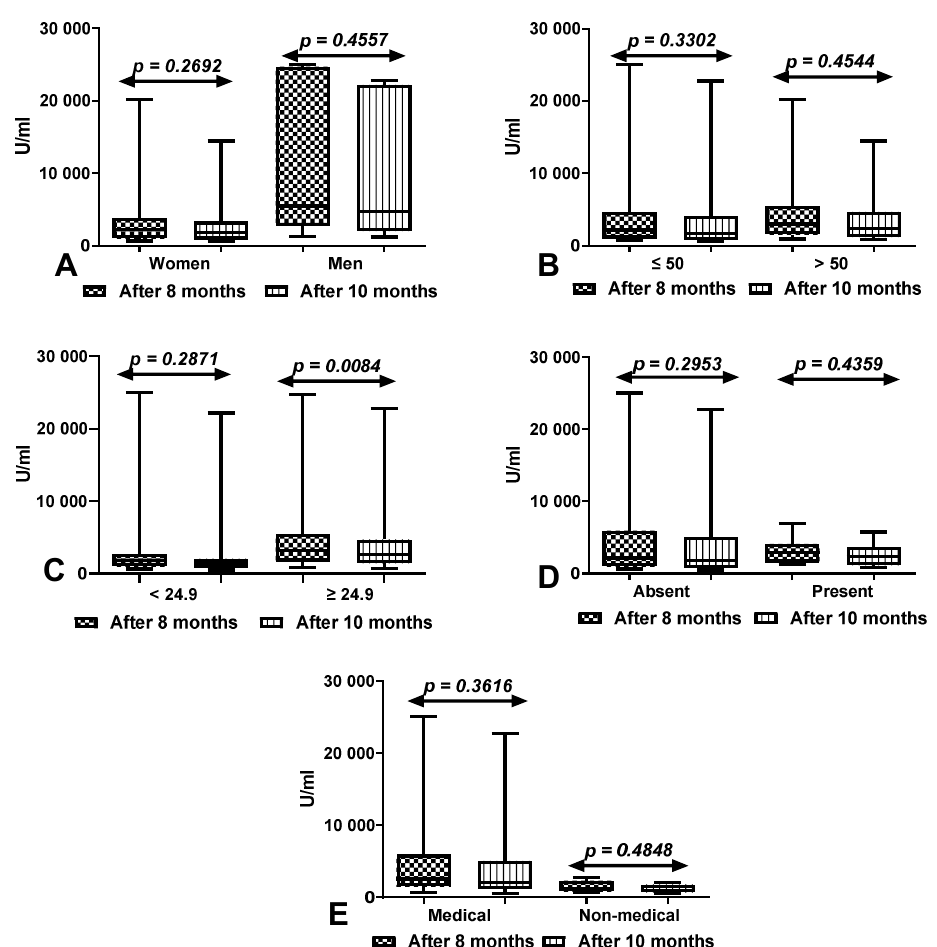
Figure 3. ( A ) Comparison of total anti-SARS-CoV-2 antibody levels between first (after 8 months) and second determination (after 10 months) in the groups of women and men with a history of COVID-19. The data are presented as median (minimum–maximum). ( B ) Comparison of total anti- SARS-CoV-2 antibody levels between first (after 8 months) and second determination (after 10 months) in the groups of patients under and over the age of 50 with a history of COVID-19. The data are presented as median (minimum–maximum). ( C ) Comparison of total anti-SARS-CoV-2 an- tibody levels between first (after 8 months) and second determination (after 10 months) in the groups of patients with normal and increased BMI with a history of COVID-19. The data are pre- sented as median (minimum–maximum). ( D ) Comparison of total anti-SARS-CoV-2 antibody levels between first (after 8 months) and second determination (after 10 months) in the groups of patients with and without coexisting diseases with a history of COVID-19. The data are presented as median (minimum–maximum). ( E ) Comparison of total anti-SARS-CoV-2 antibody levels between first (af- ter 8 months) and second determination (after 10 months) in the groups of medical and non-medical workers with a history of COVID-19. The data are presented as median (minimum–maximum).